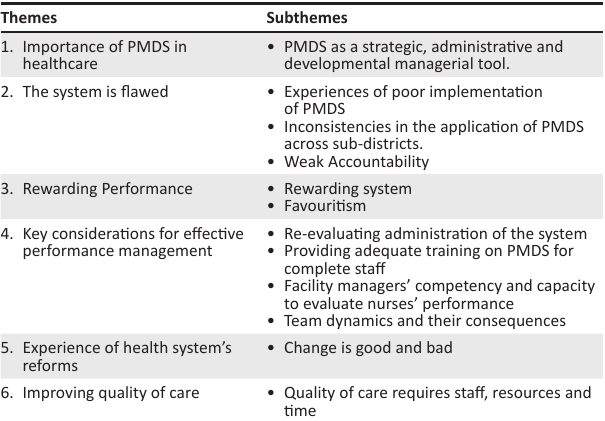
TABLE 2: Themes and